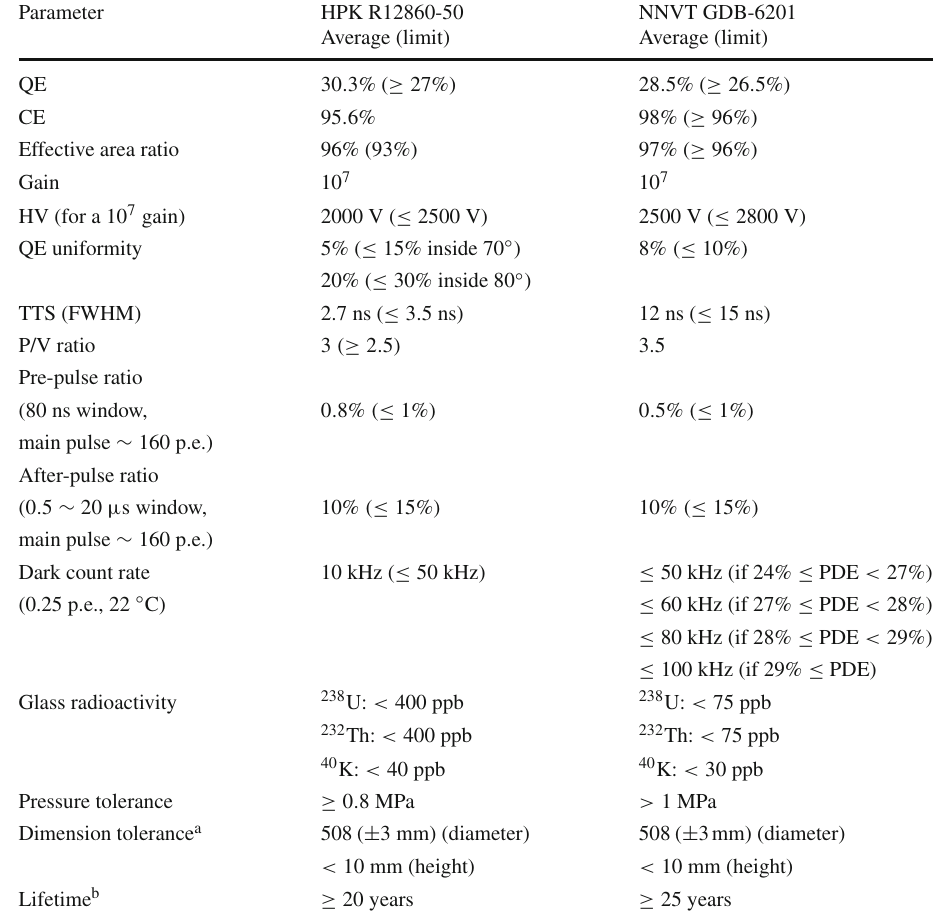
criteria for JUNO 20-inch